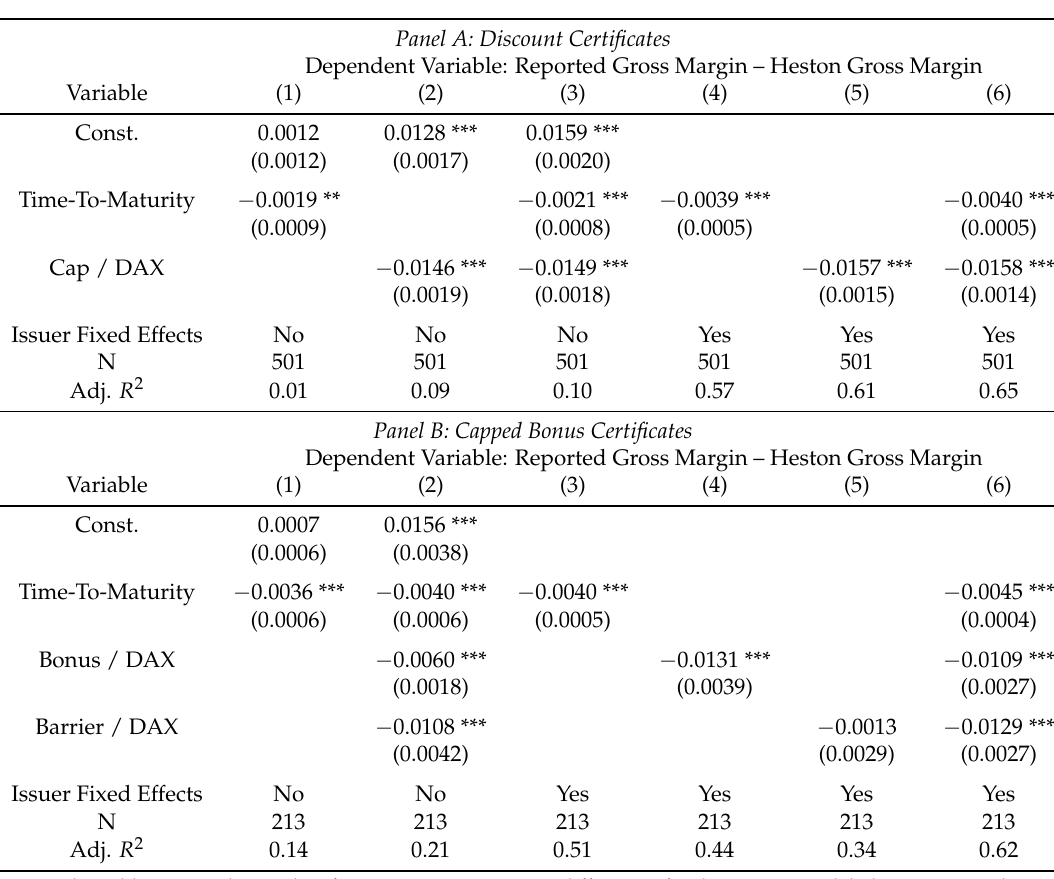
Table 4. Regression Analysis of Gross Margin